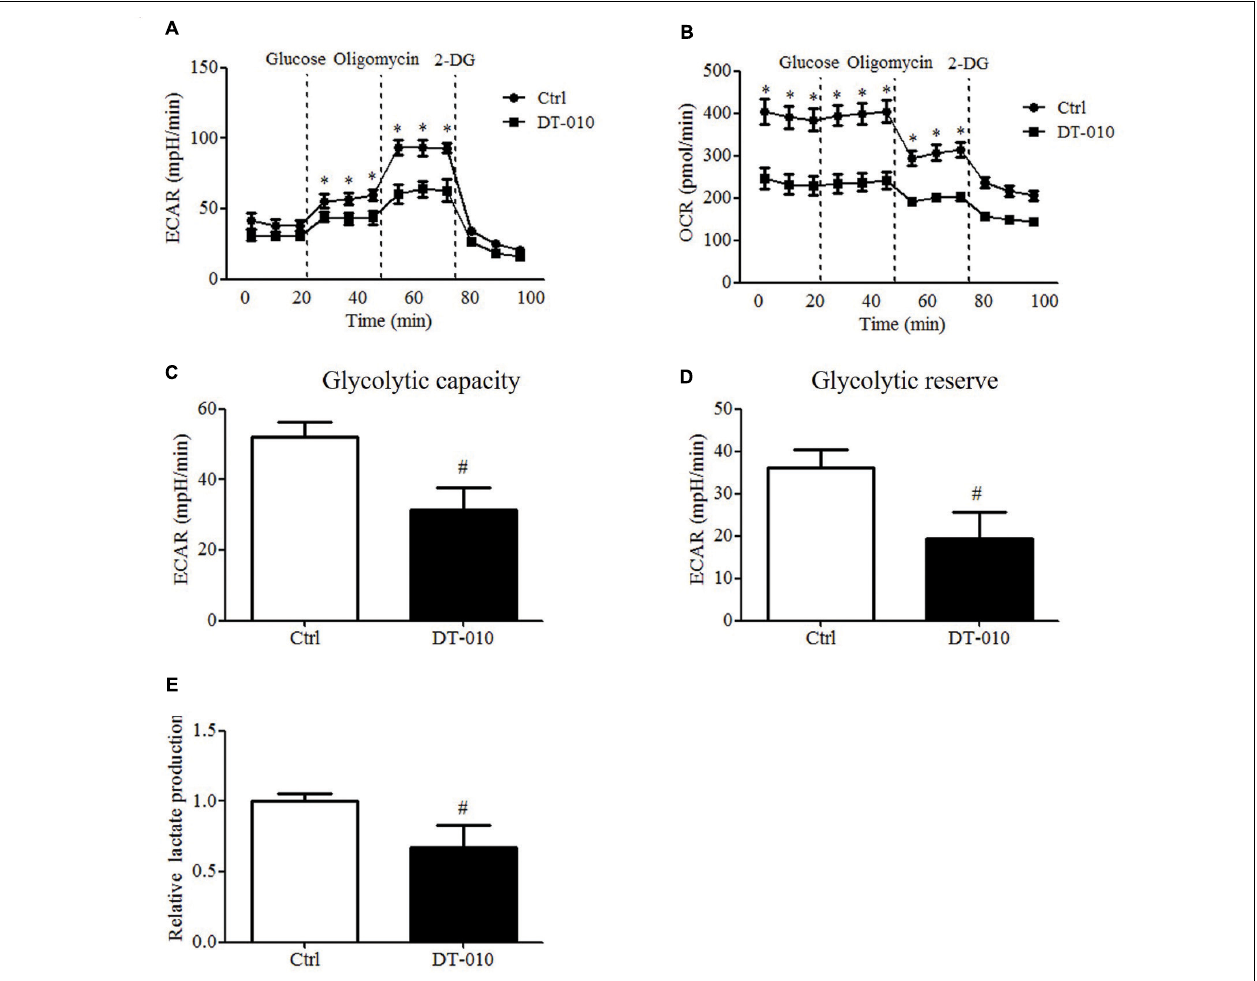
FIGURE 3 | DT-010 blocked glycolytic pathway of MCF-7 cells. MCF-7 cells were treated with DT-010 for 12 h, and the ECAR (A) and OCR (B) were measured with XF24 extracellular flux analyzer. ∗ P < 0.05 vs. DT-010 treated group. (C,D) The glycolytic capacity and glycolytic reserve in MCF-7 cells were calculated. # P < 0.05 vs. Ctrl. (E) MCF-7 cells were treated with DT-010 for 12 h. Levels of lactate were measured according to lactate assay kit. # P < 0.05 vs.